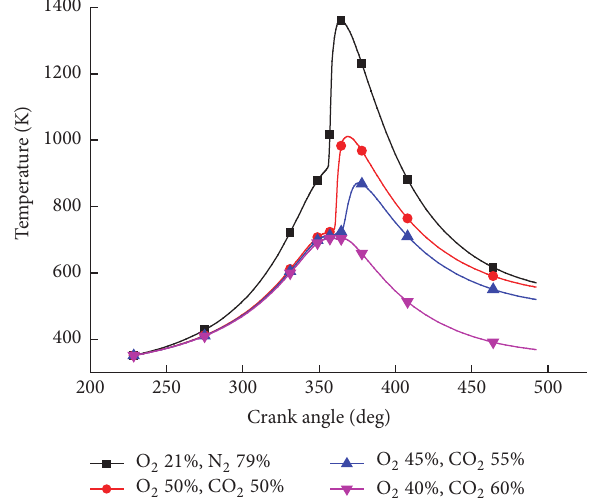
Figure 3: Curve of pressure under different O 2 volume fraction.